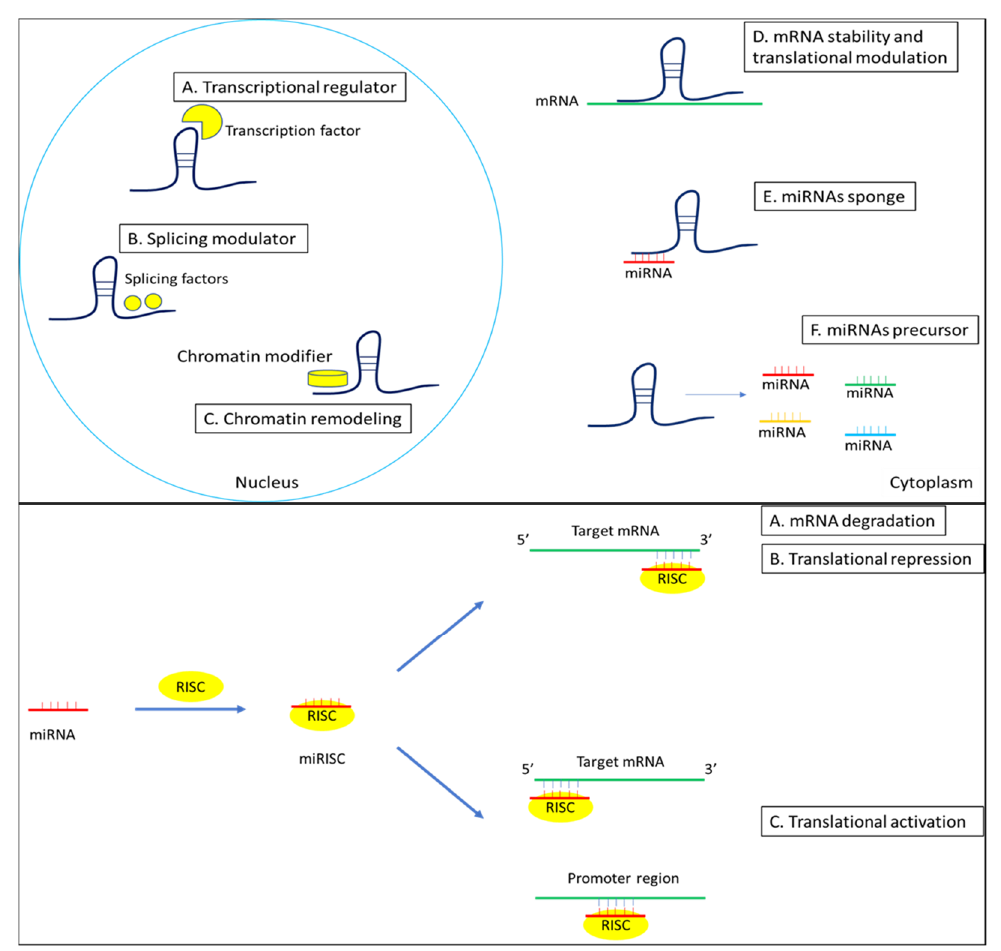
Figure 1. LncRNA ( above ) and miRNA ( below ) mechanisms of action in regulation of gene expression. MicroRNAs (miRNAs) play a key role in gene silencing because, through the mecha- nism of RNA interference, they act as negative modulators of gene expression. They